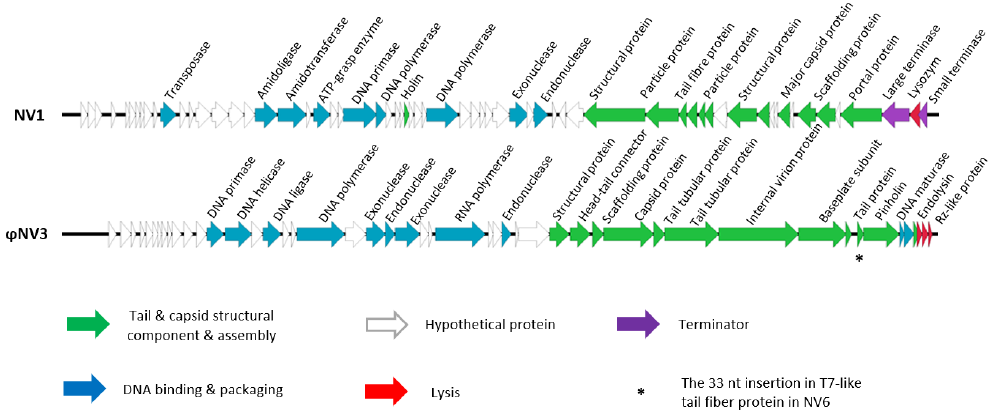
Figure 3. The genome structure of Pseudomonas phage NV1 and ϕ NV3. Diagram generated using Easyfig [69].